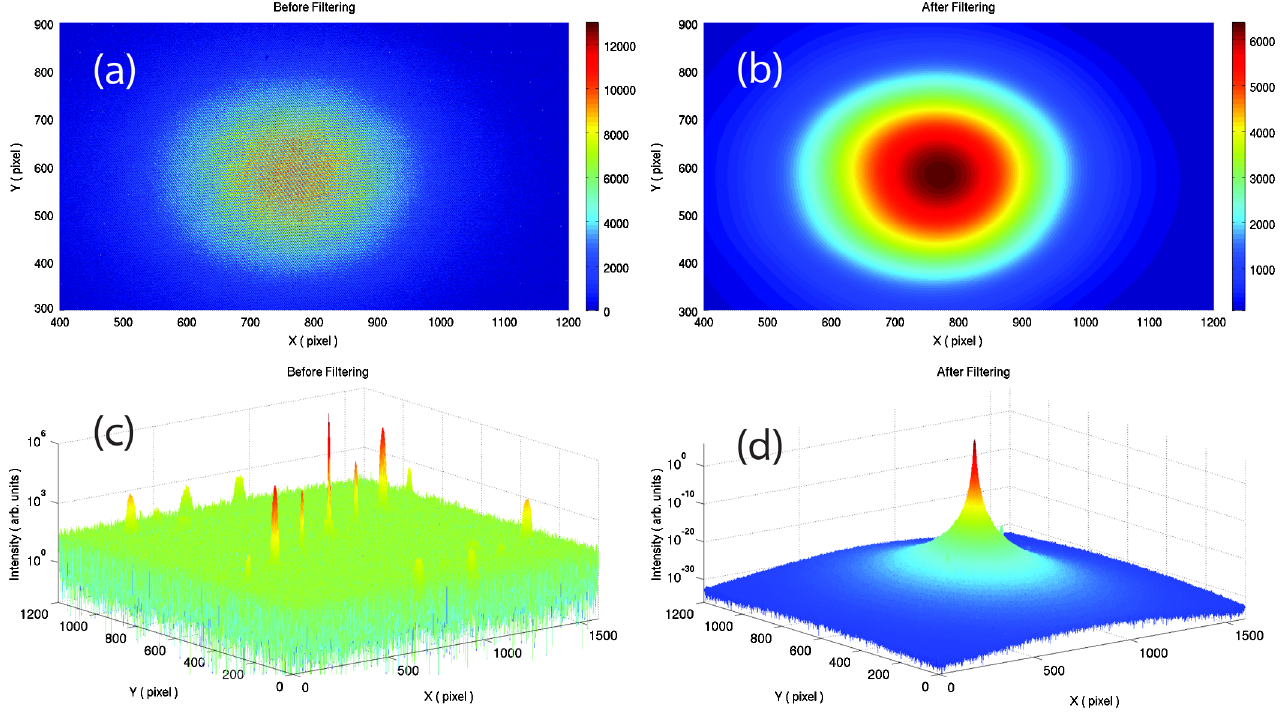
(cid:2) img (cid:2) img Þ ; (b) the image after filtering; (c) the log scale p o i